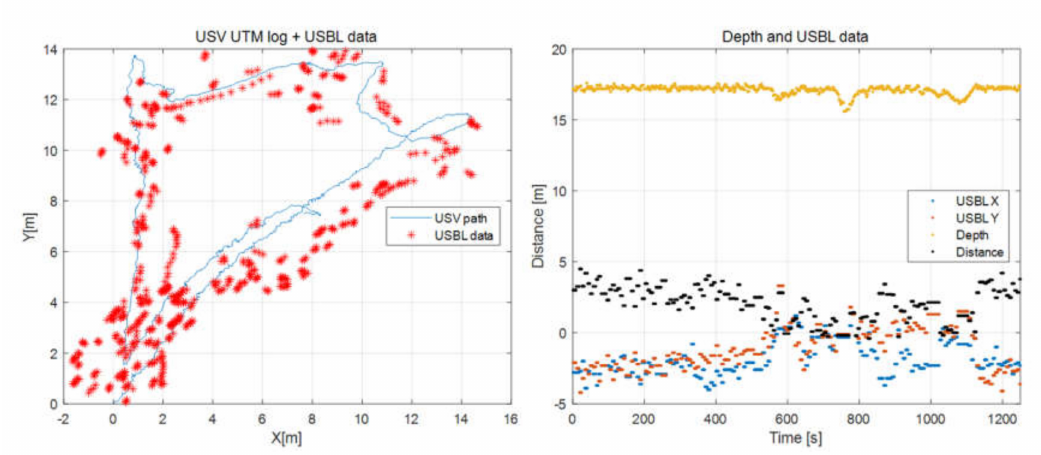
Figure 29. Relative distance control test